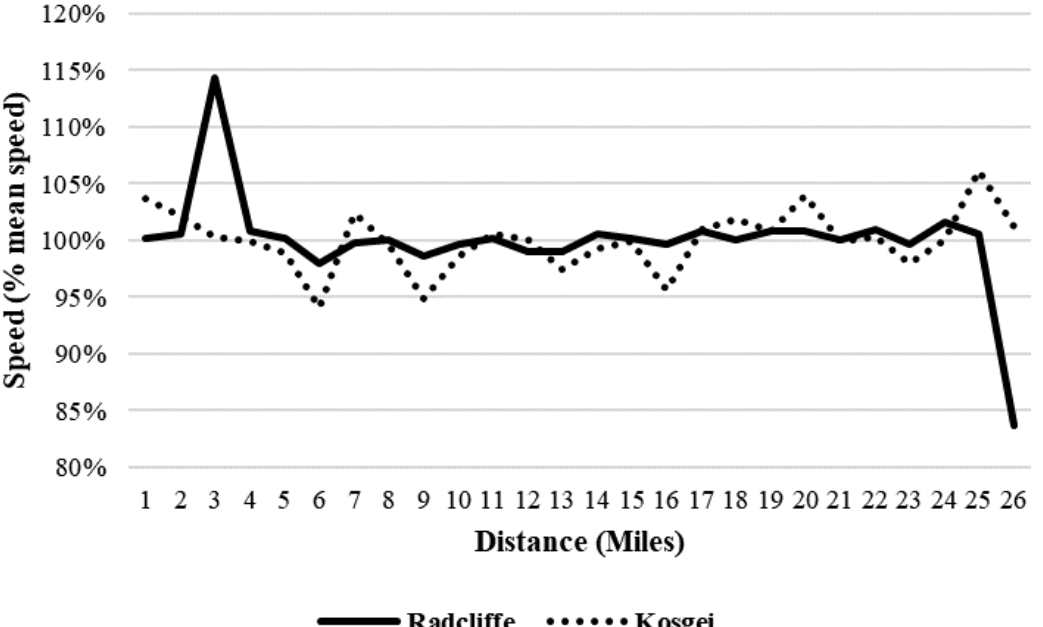
Figure 2. Speed trend and asymmetry characteristics in the world’s fastest female marathoners. The curve (solid line) represents the time course of running speed during the previous world record marathon reached by Paula Radcliffe during the London marathon in 2003. The curve (dotted line) represents the time course of running speed during the new world record reached by Brigid Kosgei during the Chicago marathon in 2019. These curves represent the percentage of the mean speed achieved in each distance unit during the entire marathon.